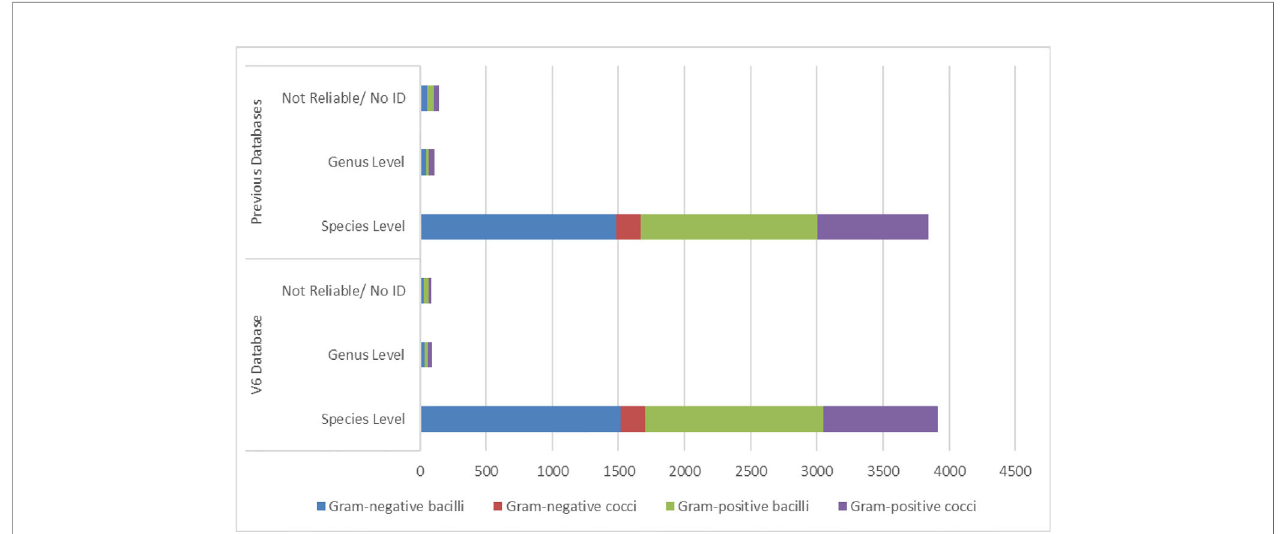
FIGURE 1 | Representation of the species-level (Sp) and genus-level (Gn) identi fi cation rates as well as the percentages of not reliable or no identi fi cations (NR/No ID) using the V6 database and previous databases. The V6 database provided 95.9%, 2.3% and 1.8% Sp, Gn and NR/No ID identi fi cation for Gram-negative bacilli (in blue) vs 93.9%, 2.8% and 3.2% with previous libraries. For Gram-positive cocci (in red), the rates of Sp (99.5%), Gn (0.0%) and NR/No ID (0.5%) did not change with the different databases. However, for Gram positive bacilli (in green) -Sp 95.8%, Gn 1.6% and NR/No ID 2.6%- and specially for Gram positive cocci (in purple) -Sp 94.1%, Gn 3.8% and NR/No ID 2.1%- the rates of correct identi fi cations improved when the V6 database was implemented in comparison with previous libraries (Sp 94.8%, Gn 1.7% and NR/No ID 3.5% for Gram positive bacilli and Sp 91.4%, Gn 4.3% and NR/No ID 4.2% for Gram positive